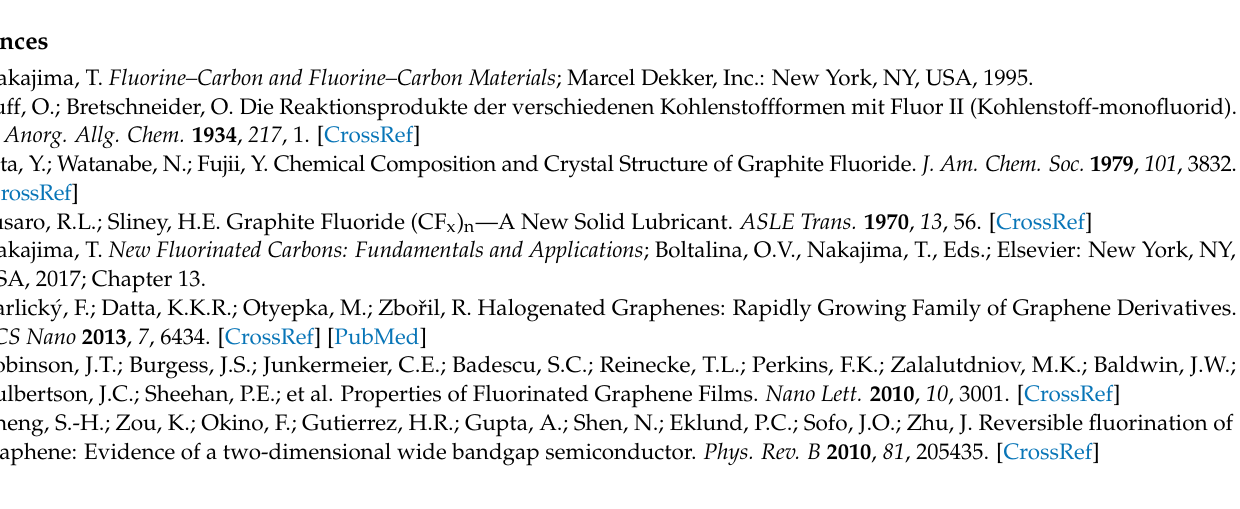
MEGF; Figure S2: SEM images of MEGF-L and MEGF-S; Figure S3: XRD patterns of GF-L and MEGF- L and GF-S and MEGF-S; Figure S4: XPS surveys, C 1s and F 1s spectra of GF-L, GF-S, MEGF-L, and MEGF-S; Figure S5: N 2 adsorption-desorption isotherms of activated carbon, MEGF-L, and